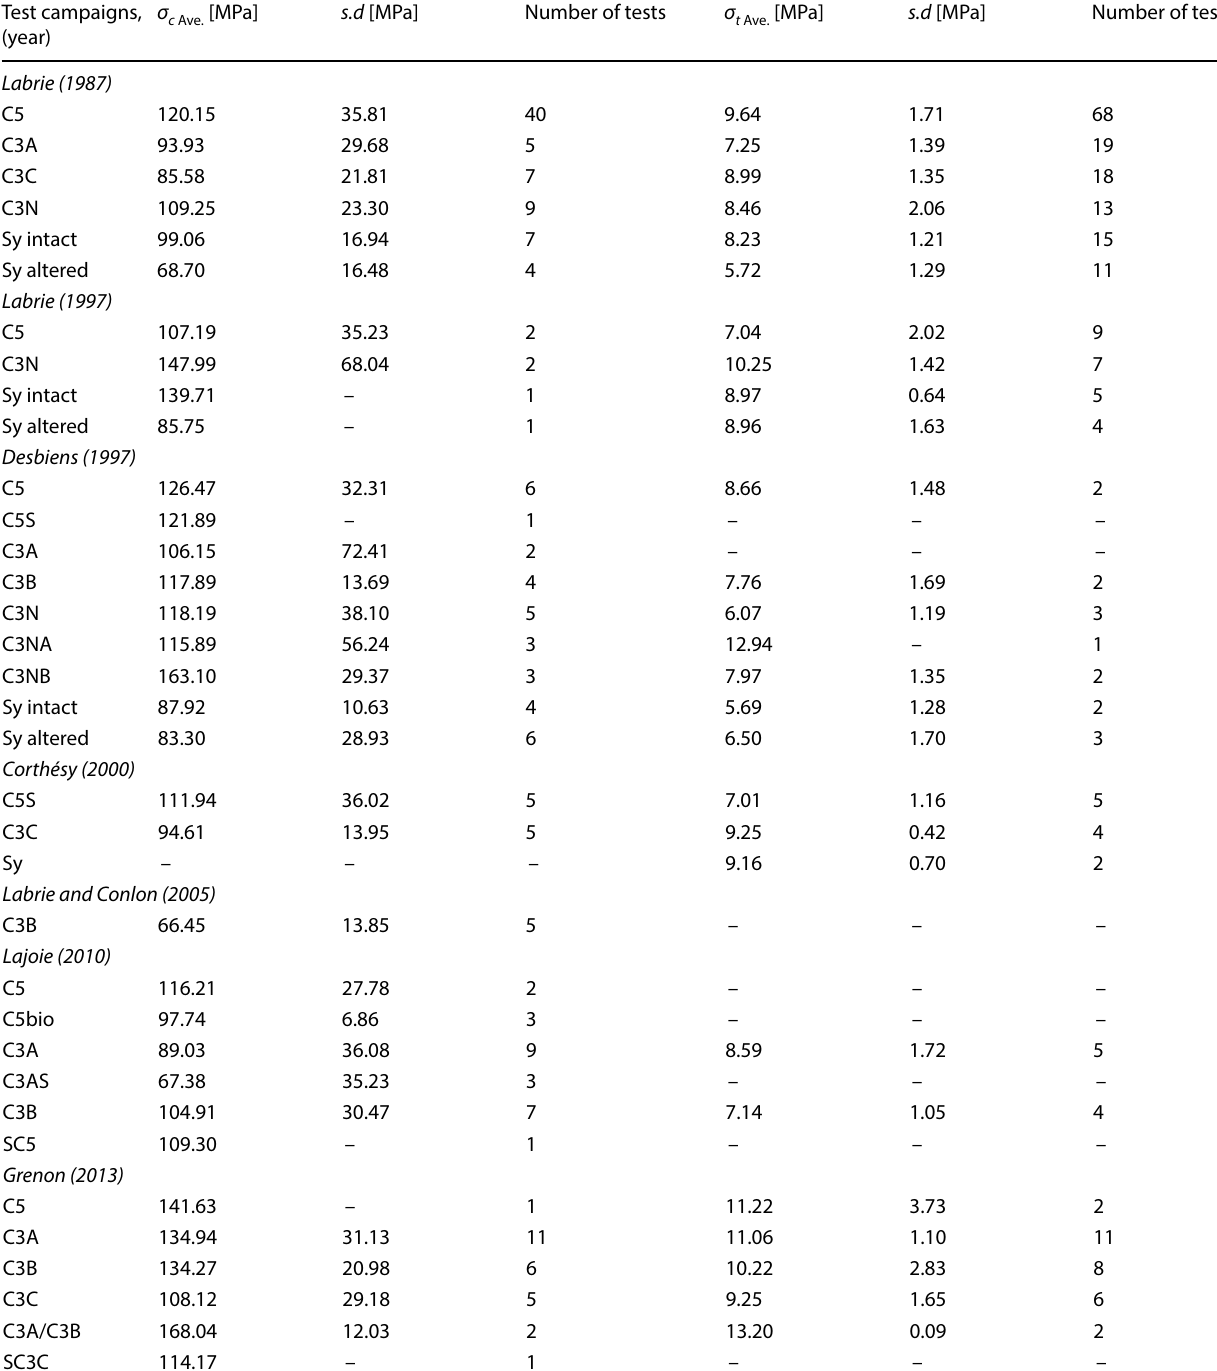
Table 4 The average uniaxial compressive and tensile strength values for each lithological